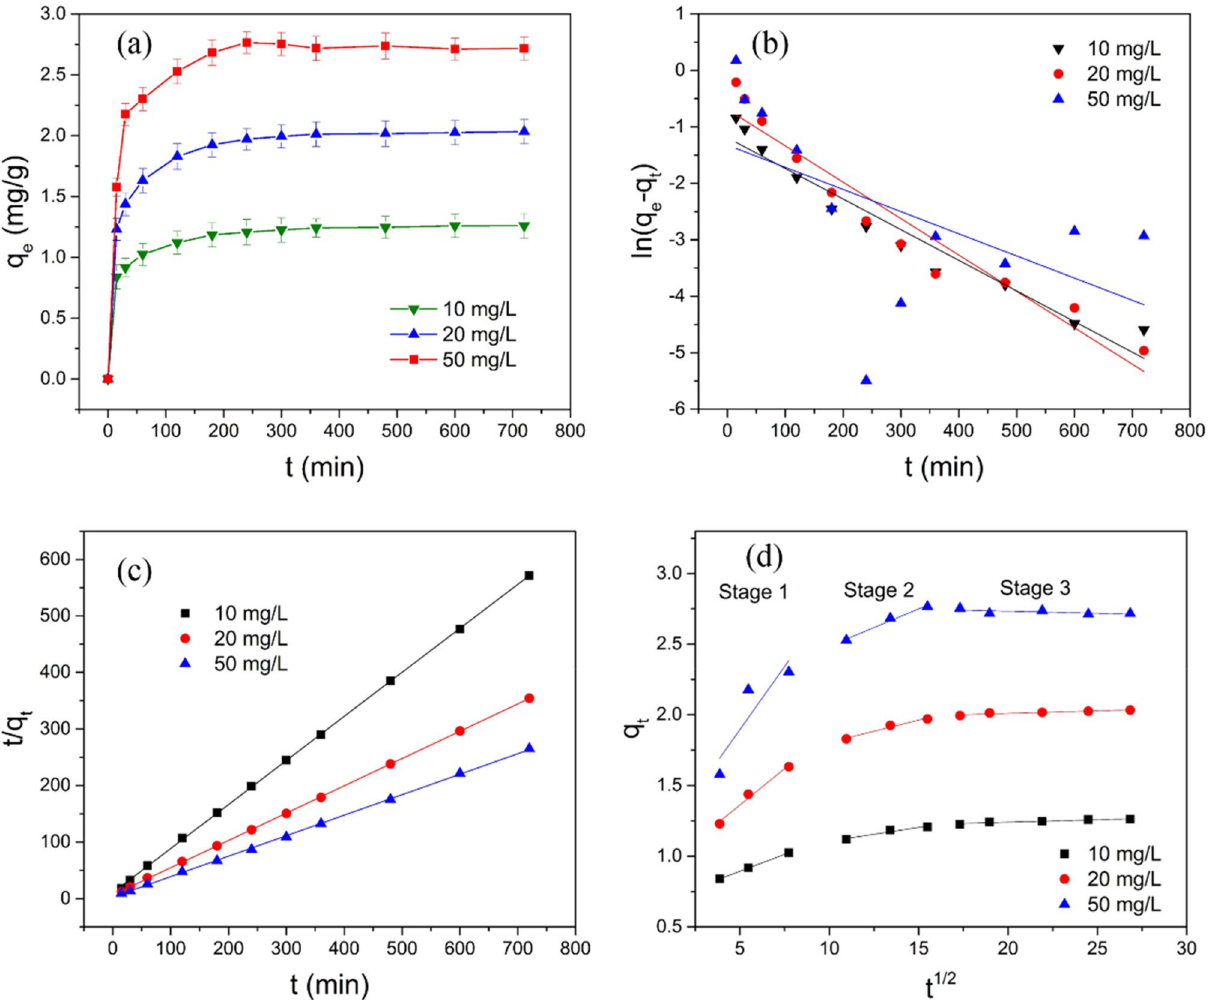
Figure 5. ( a ) Effect of contact time on the removal of Sb(III) by GAD. ( b ) Pseudo-first-order reaction model. ( c ) Pseudo-second-order reaction model. ( d ) Intraparticle diffusion model (pH = 6; dosage = 1600 mg/200 mL dry weight; Sb(III) concentration = 10, 20, 50 mg/L; temperature = 298 k; rotation speed = 150 rad/min; contact time = 720